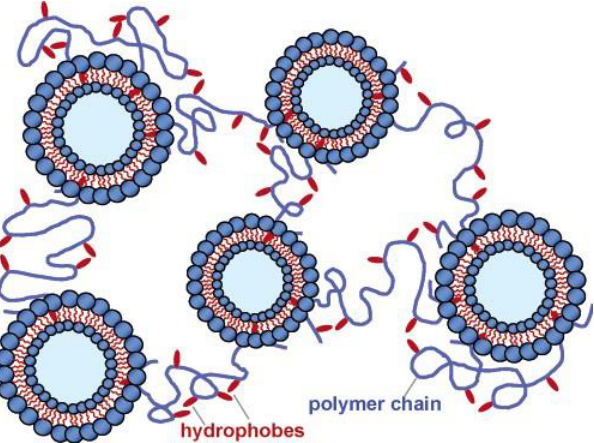
Figure 3. Proposed structure of the network formed upon addition of hydrophobically modified chitosan to vesicles. Polymer hydrophobes are shown to be embedded in vesicle bilayers, thus building a connected network of vesicles. Each vesicle acts as a multifunctional cross-link in the network. Reprinted with permission from reference [71]. Copyright 2005 American Chemical Society.